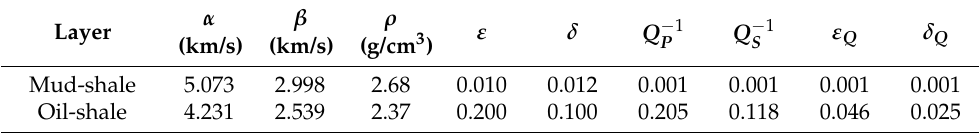
Table 1. The parameters of attenuated anisotropic model 1.